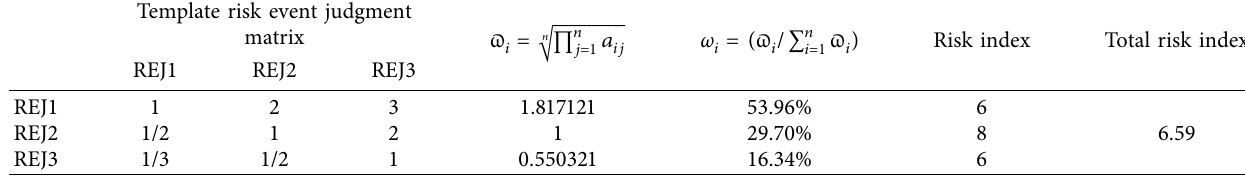
Table 29: Template risk judgment matrix.